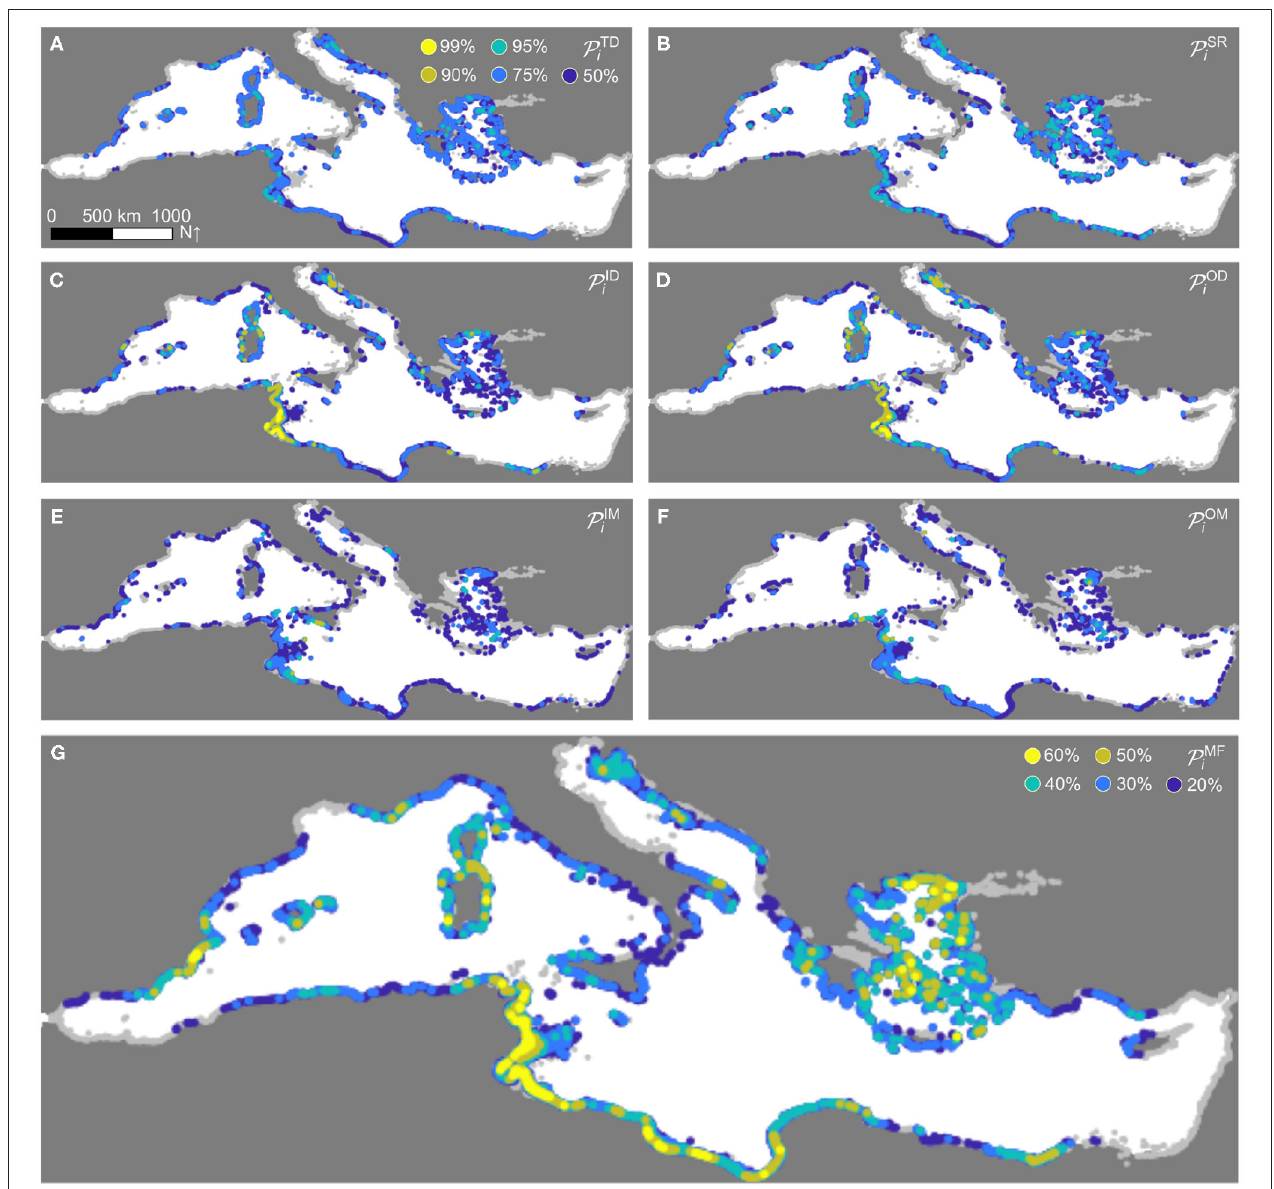
FIGURE 7 | Sensitivity of the hotspot identification procedure to changes in the parameters of the metapopulation model. (A) Abundance hotspots. (B) Self-retention hotspots. (C) Indegree hotspots. (D) Outdegree hotspots. (E) Inbound displacement hotspots. (F) Outbound displacement hotspots. Colors identify sectors that, for a given metric Q ∈ { TD,SR,ID,OD,IM,OM } , are above the k -th percentile ( k ∈ { 50,75,90,95,99 } ) of the P Q i across-sector distribution in at least k % of the n s = 10 3 simulations performed with parameter values randomly (and uniformly) drawn from the ranges reported in Table 1 ( P Q score). Sectors for which P Q i < 50 % are shown in light gray. (G) Multi-functional hotspots, identified as sectors that are above the k -th percentile in the across-sector distribution of the multi-functional percentile score P MF i ( k ∈ { 20,30,40,50,60 } ) in at least k % of the simulations ( P MF score). Sectors for which P MF i < 20 % are shown in light